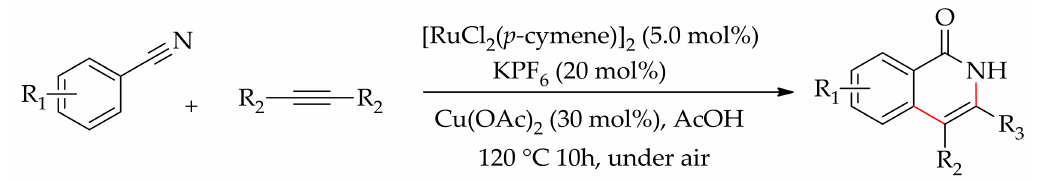
Scheme 87. Ruthenium-catalysed aerobic annulation of aromatic nitriles with